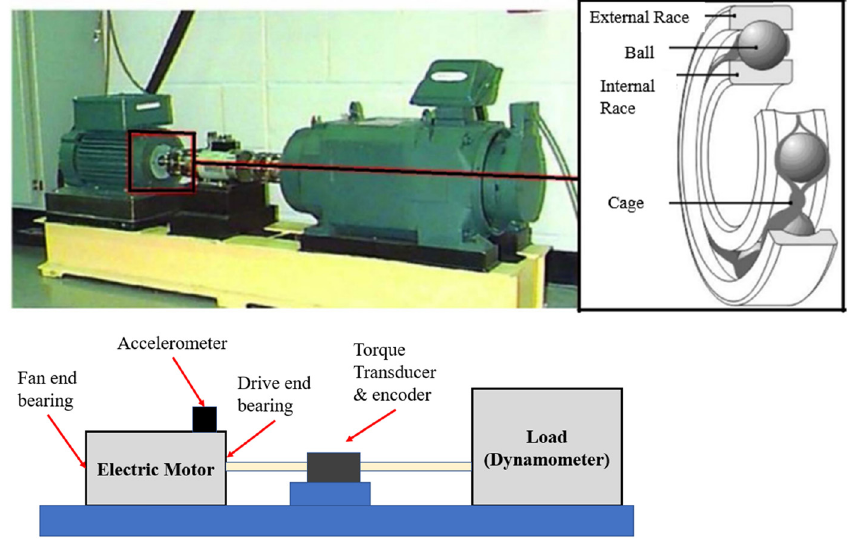
Figure 8: Test con fi guration.